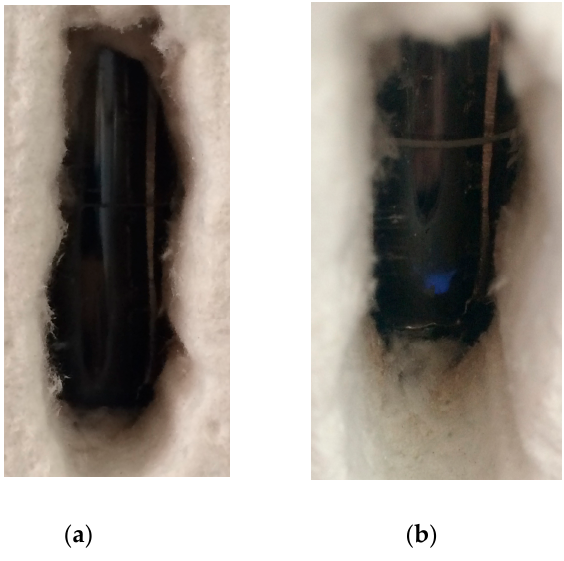
Figure 3. Photos of stable combustion flame, v = 0.2 m/s and Φ = 1.0. ( a ) Front view; ( b ) oblique view (downward).